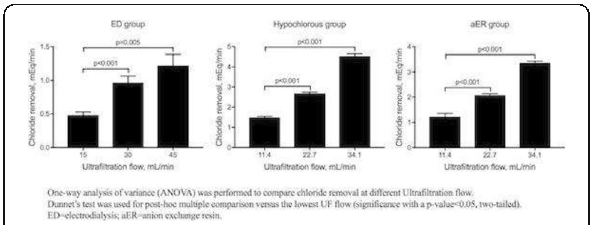
Fig. 1 (abstract 0297). Chloride removal by 3 different extracorporeal